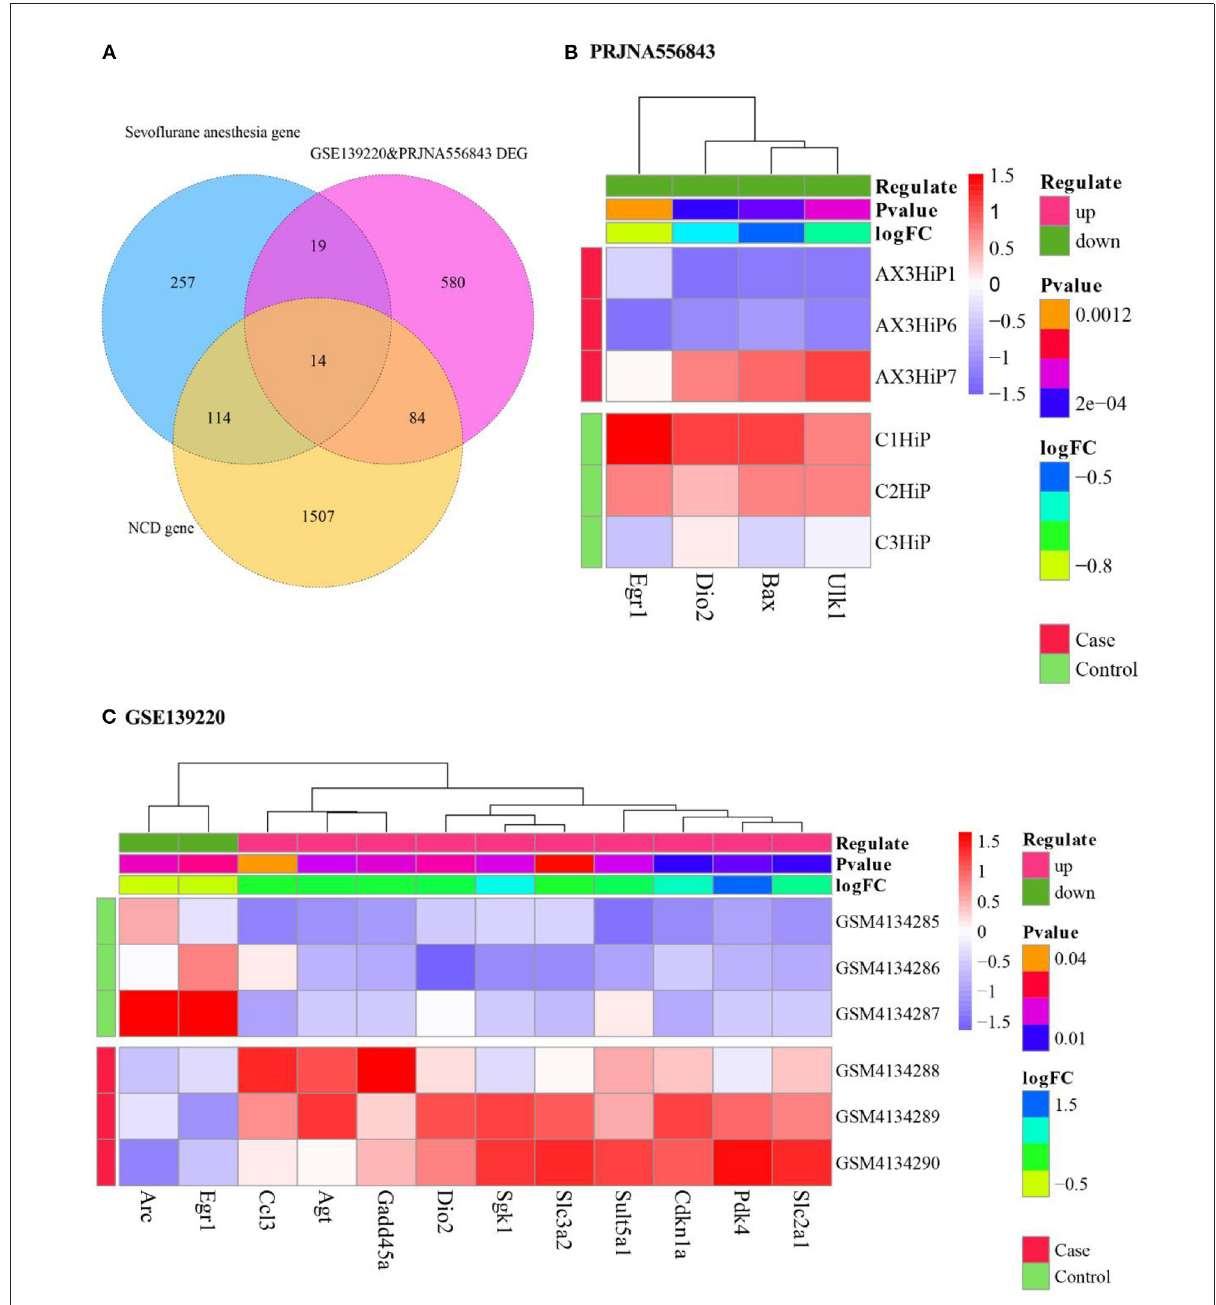
FIGURE2 Cross talk genes linking Sevoflurane anesthesia and NCD. (A) Screening of cross-talk genes. PRJNA556843 differential gene; (B) heat map of cross-talk gene expression in PRJNA556843; (C) heat map of cross-talk gene expression in